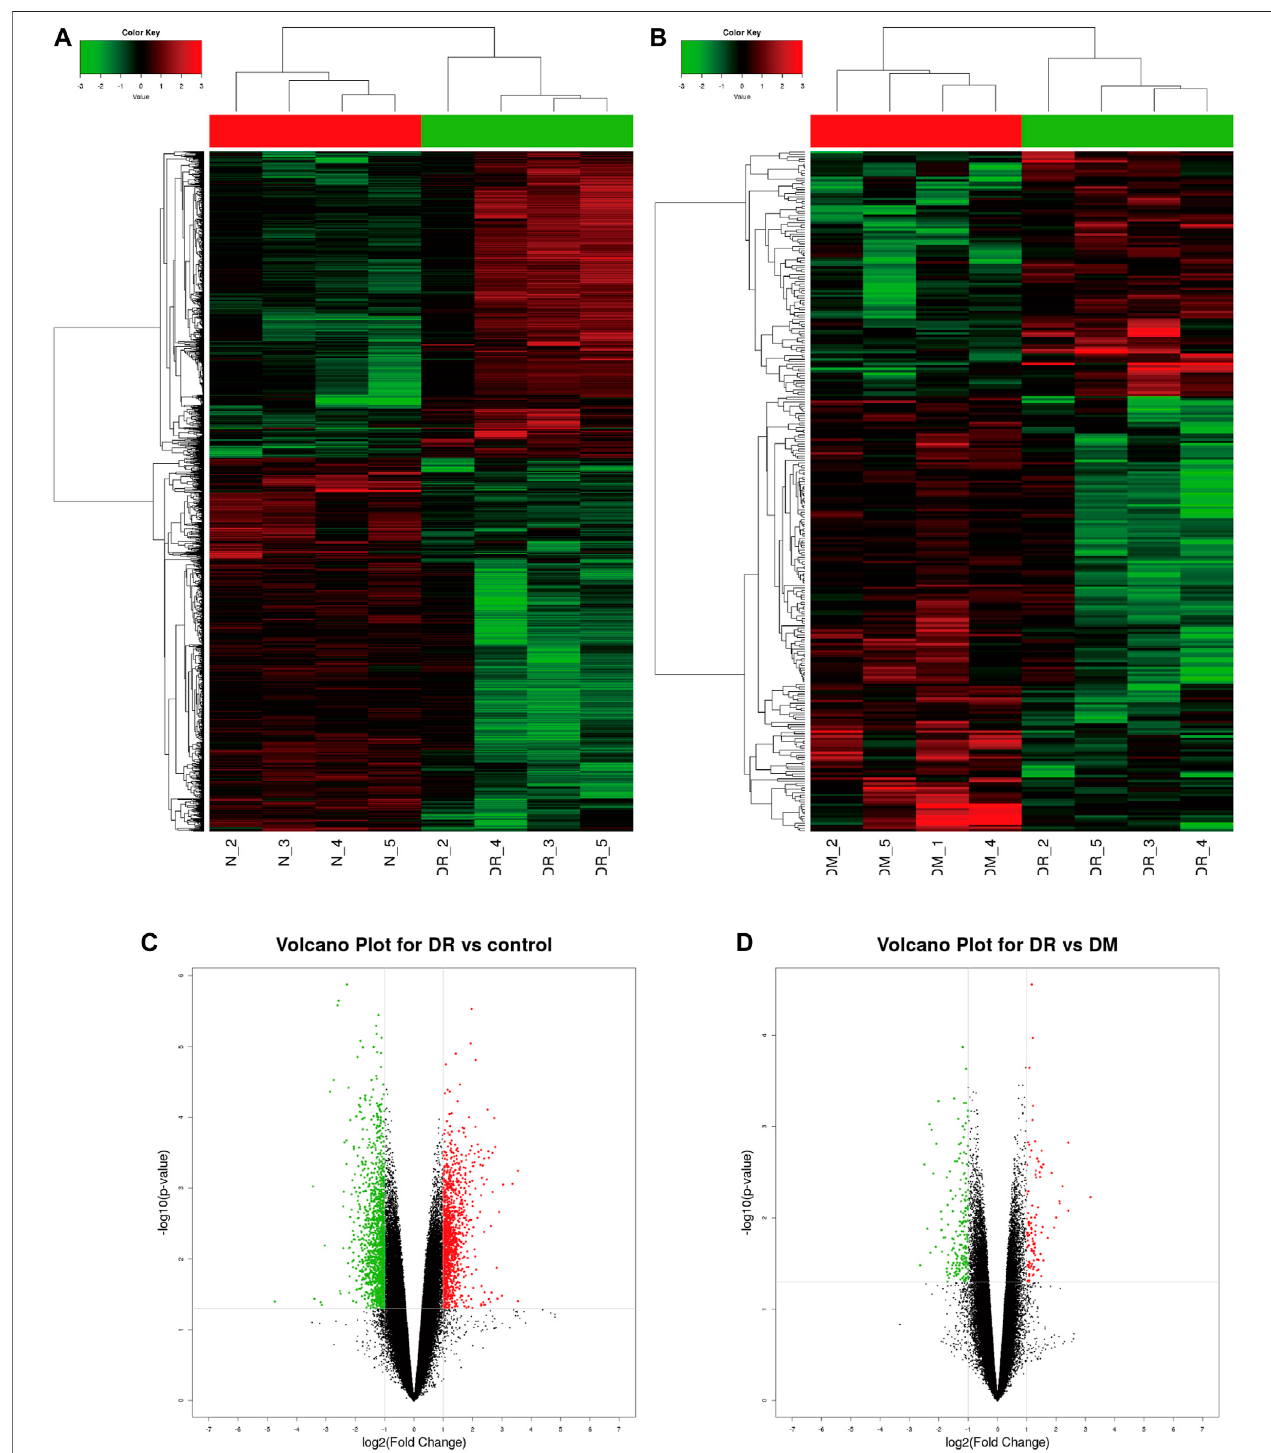
FIGURE1| Pro fi le ofcircRNA level inDRsamples. (A) Identi fi edcircRNAs betweenDRandcontrolgroupsbyheatmapanalyzes. (B) Identi fi edcircRNAsbetween DRandDMgroupsbyheatmapanalyzes. (C) DifferentiallyexpressedcircRNAs betweenDRandcontrolgroupsbyVolcanomapanalysis; (D) Thedifferentlyexpressed circRNAs between DR and DM groups by Volcano map analysis. The red dots represent signi fi cant upregulation, and green dots represent signi fi cant downregulation.